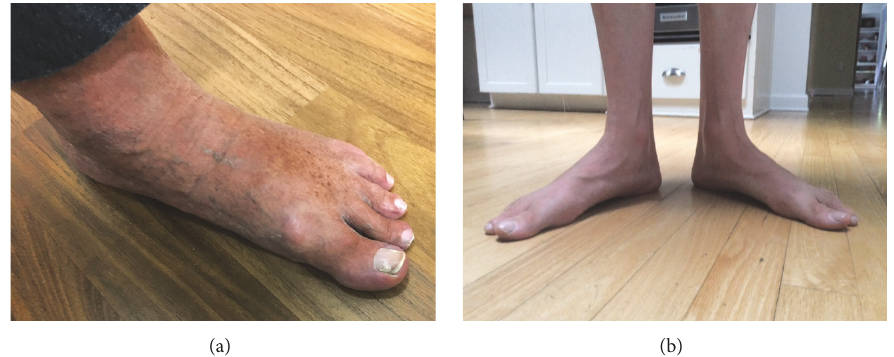
Figure 1: Flat feet with low arches in case 2 (a) and case 3